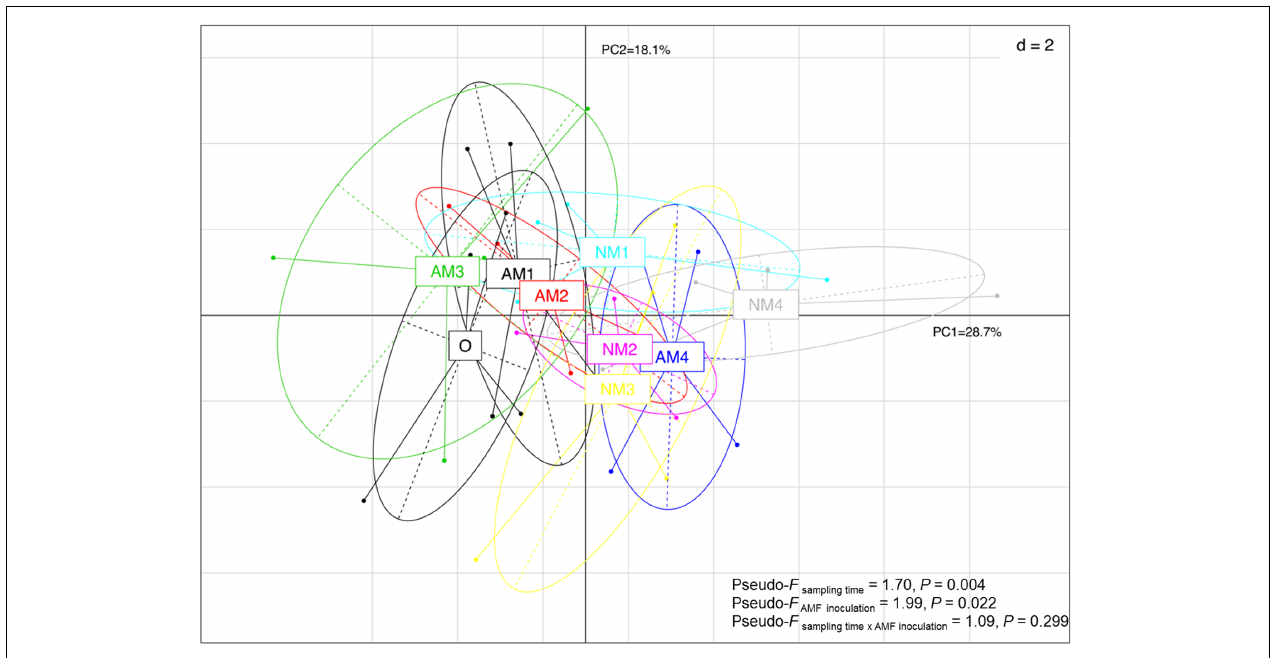
FIGURE 4 | Principal component analyses (PCA) of soil bacterial community composition structure under different treatments and over different sampling times based on all the OTUs. Abbreviations: AM represents the treatment inoculated with arbuscular mycorrhizal fungi, NM represents the uninoculated treatment, while O stands for the original soil collected from the forest. Different numbers (1, 2, 3, and 4) represent the different sampling times (T 90 , T 120 , T 150 , and T 180 , respectively). The data is shown at mean value for each axis ( ± SE, n = 4).